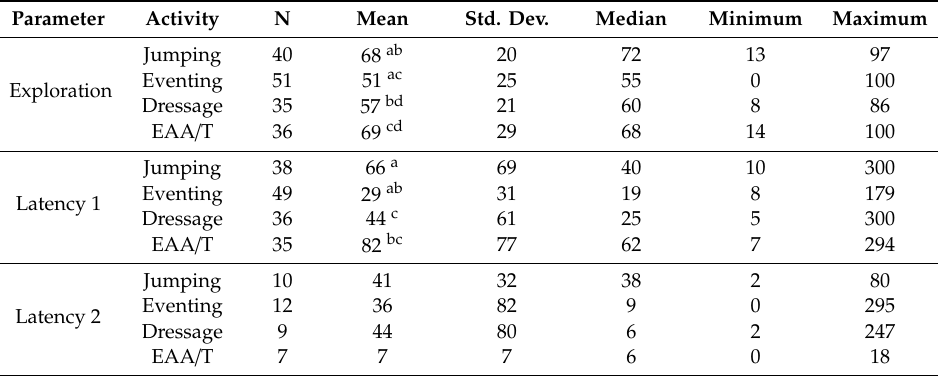
Table 7. Behavioral data results of experiment